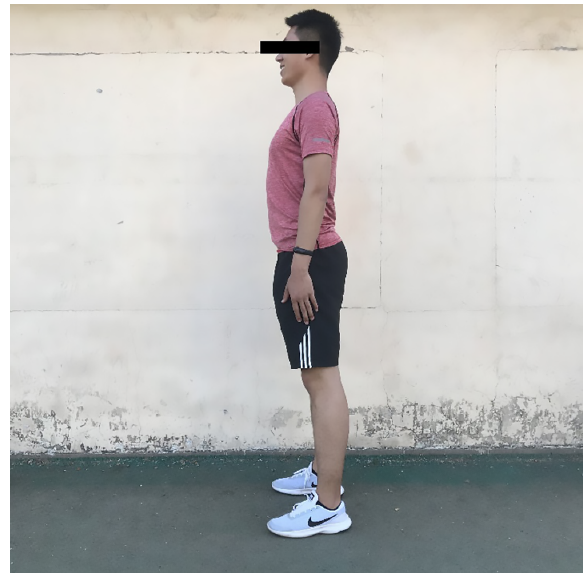
Fig. 3. Start position.